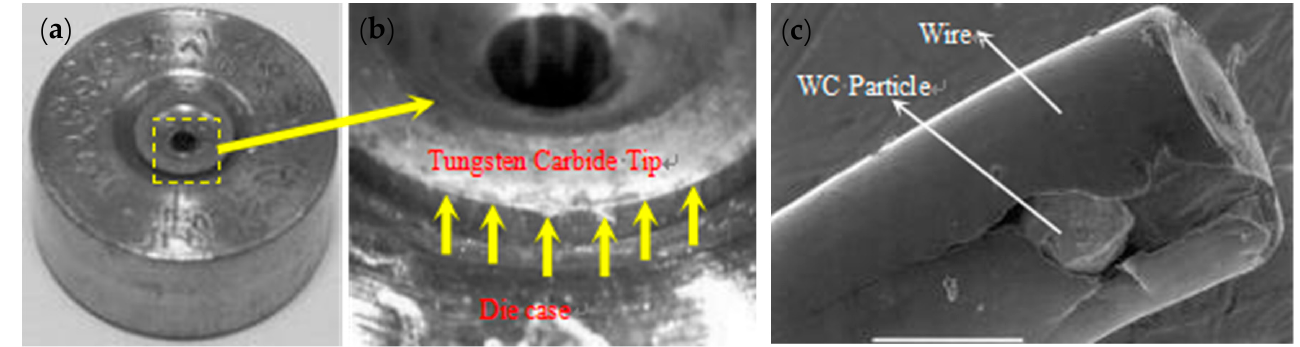
Figure 36. Die failure and steel wire fracture during steel cord drawing: ( a ) mold failure, ( b ) mold damage, and ( c ) steel wire with WC particles embedded in the surface. Reprinted with permission from ref. [88].